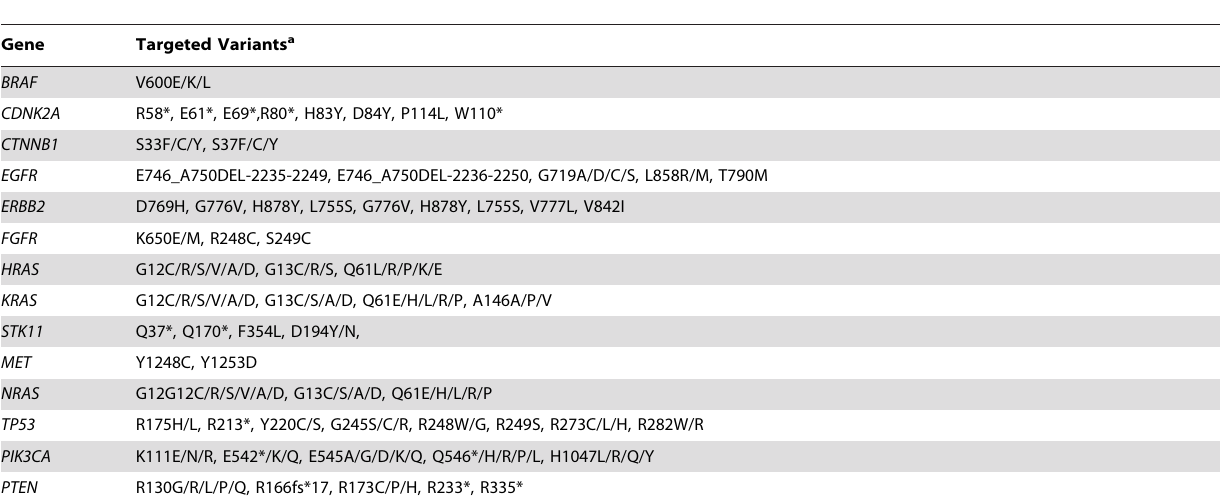
Table 1. Mutations targeted by the MALDI-TOF Panel by gene.